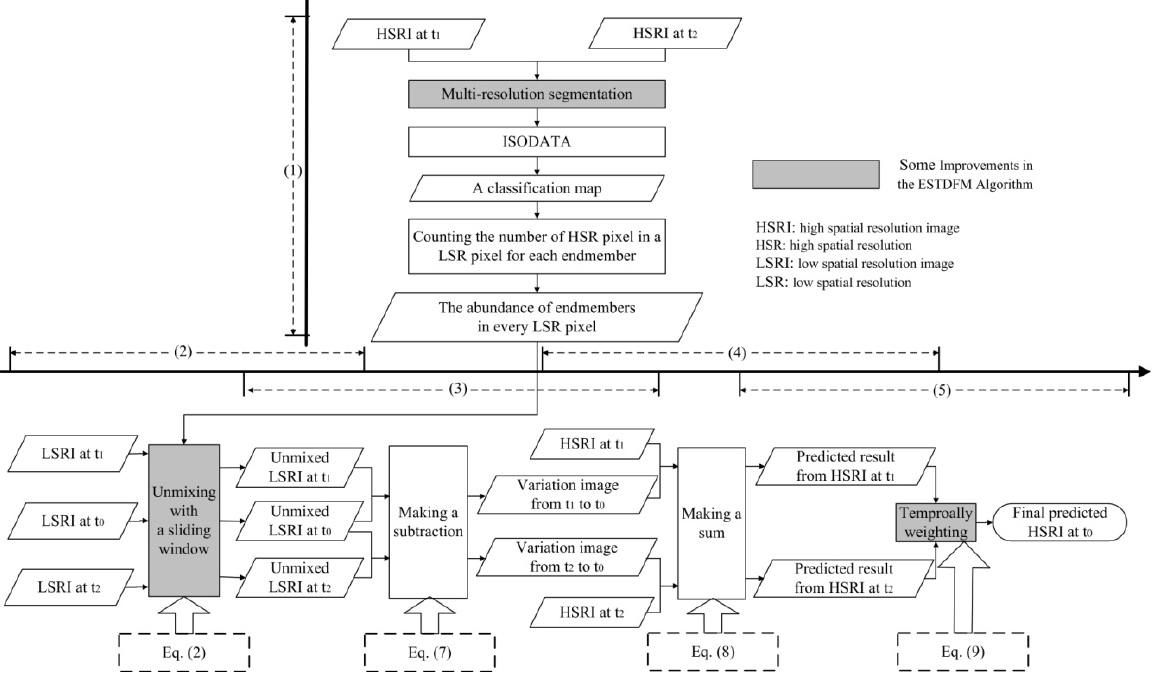
Figure 3. The flowchart of the ESTDFM